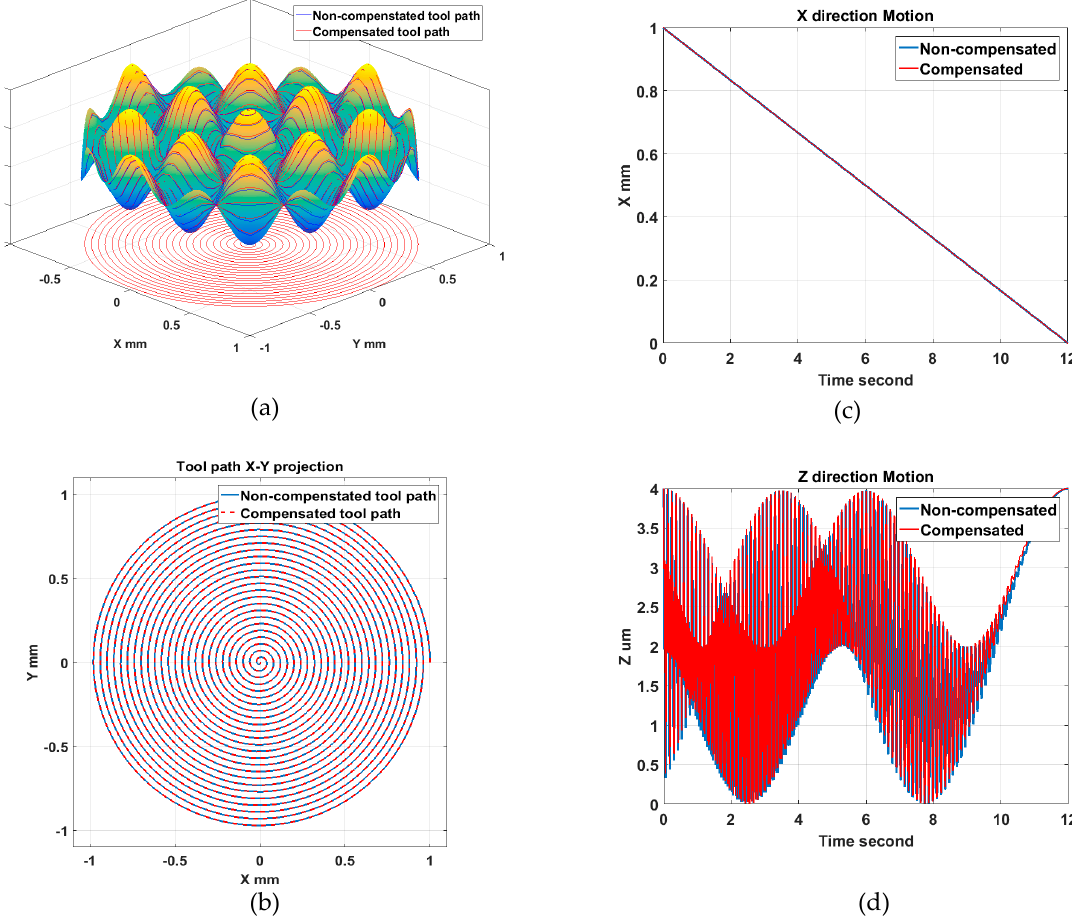
Figure 11. Z direction compensation method and tool path analysis: ( a ) Tool path; ( b ) Tool path projection; ( c ) X axis motion; ( d ) Z axis motion.